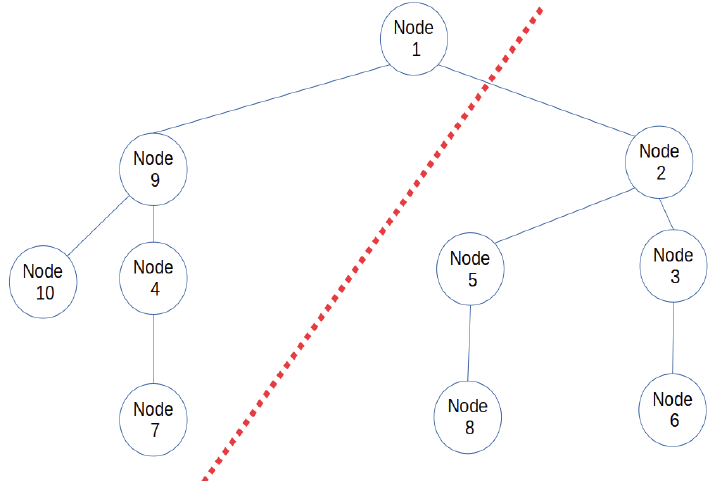
Figure 4. Sensor network